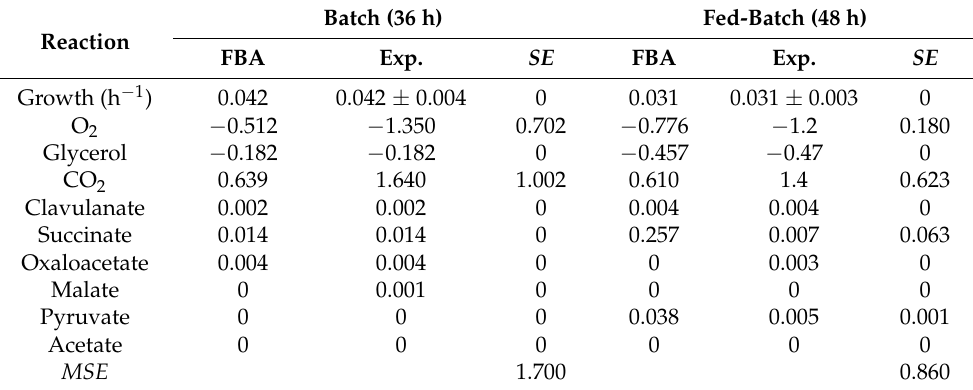
Table 2. Comparison between experimental and simulated rates in batch and fed-batch cultivations of S. clavuligerus